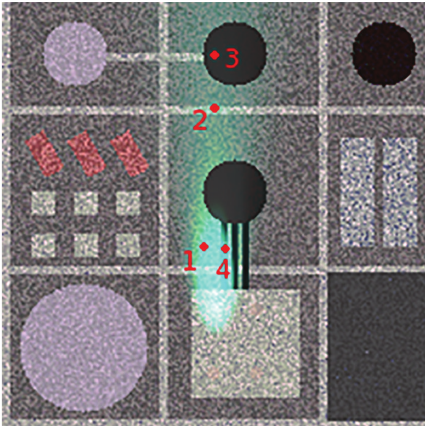
Figure 9: Positions of used pixels in the background radiance esti- mation methods